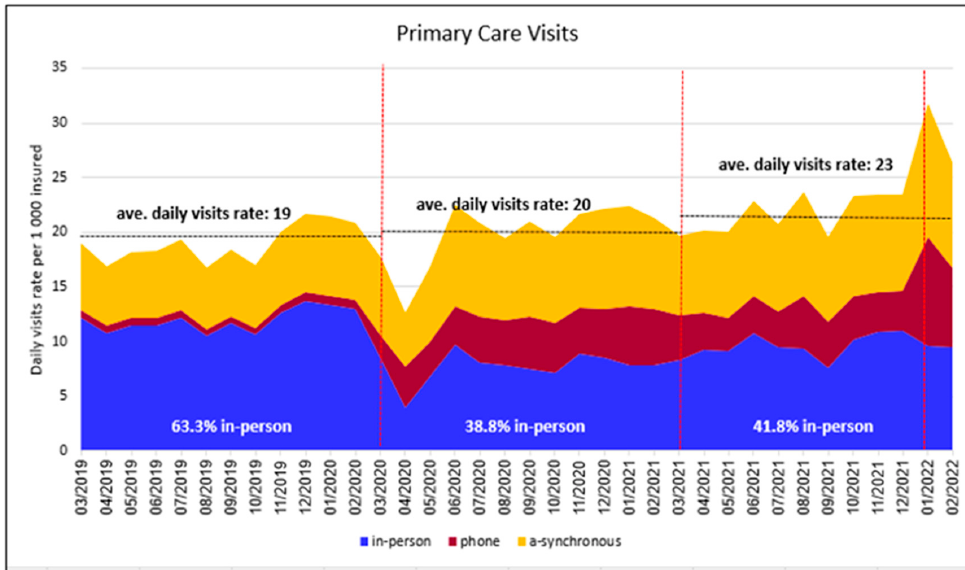
Figure 1. Primary care visits by type. Y axis: primary care visits per 1000 members. X axis: the calendar month of the visit. Blue area represents in-person visits; red area represents phone visits; and yellow area represents asynchronous communication. The dotted horizontal lines show the average visit rate in each of the three study periods. The first red dotted vertical line indicates the start of the pandemic in Israel (March 2020), the second dotted line indicates the start of the COVID-19 vaccine protective period for the majority of Israelis (March 2021), and the third dotted line indicates the start of the Omicron wave (January 2022).